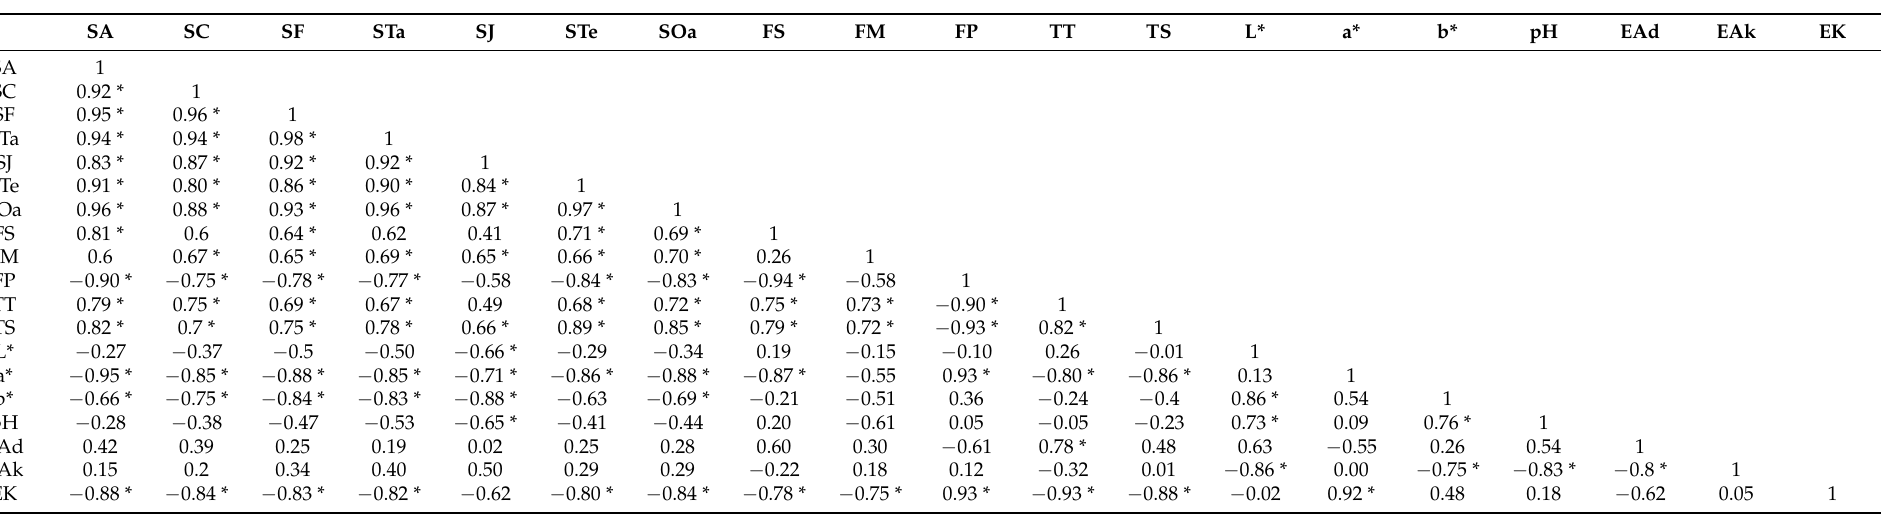
Table 4. Analysis of correlations between the fatty acid profile (SFA, MUFA, and PUFA), color parameters (L*, a*, b* and BI) and WHC, pH, weight and cooking loss, TBARS, and TPA parameters (springiness, hardness) in grilled